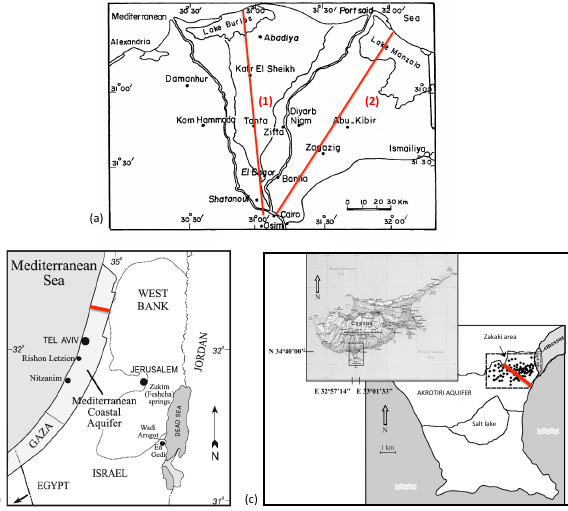
Fig. 2. Mediterranean aquifers and selected cross sections (red lines). (a) Nile Delta aquifer: (1) middle Nile Delta and (2) east Nile Delta (adapted from Sherif, 1999); (b) Israel Coastal aquifer, light grey area (left) (adapted from Yechieli and Sivan, 2011); and (c) Cyprus Akrotiri